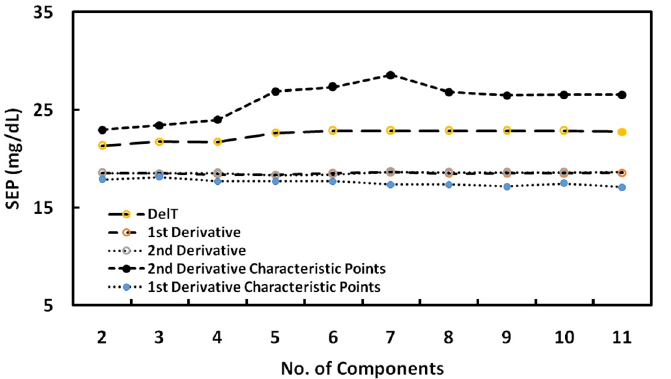
Figure 9. Standard Error of Predictions (SEPs) against a different number of principal components (PCs) achieved for Principal Component Regression (PCR) model built with different preprocessing approaches. Table 2. Comparison of performances of different PCR models.